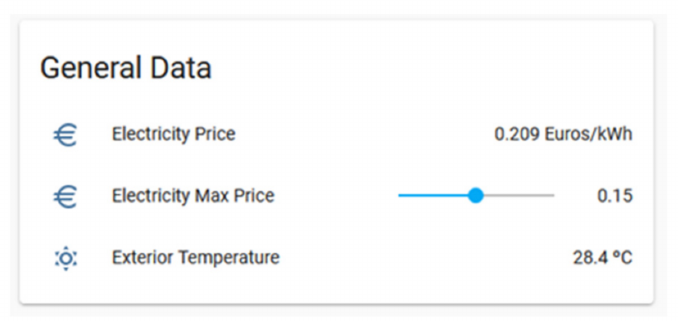
Figure 2. The Home Assistant interface for general